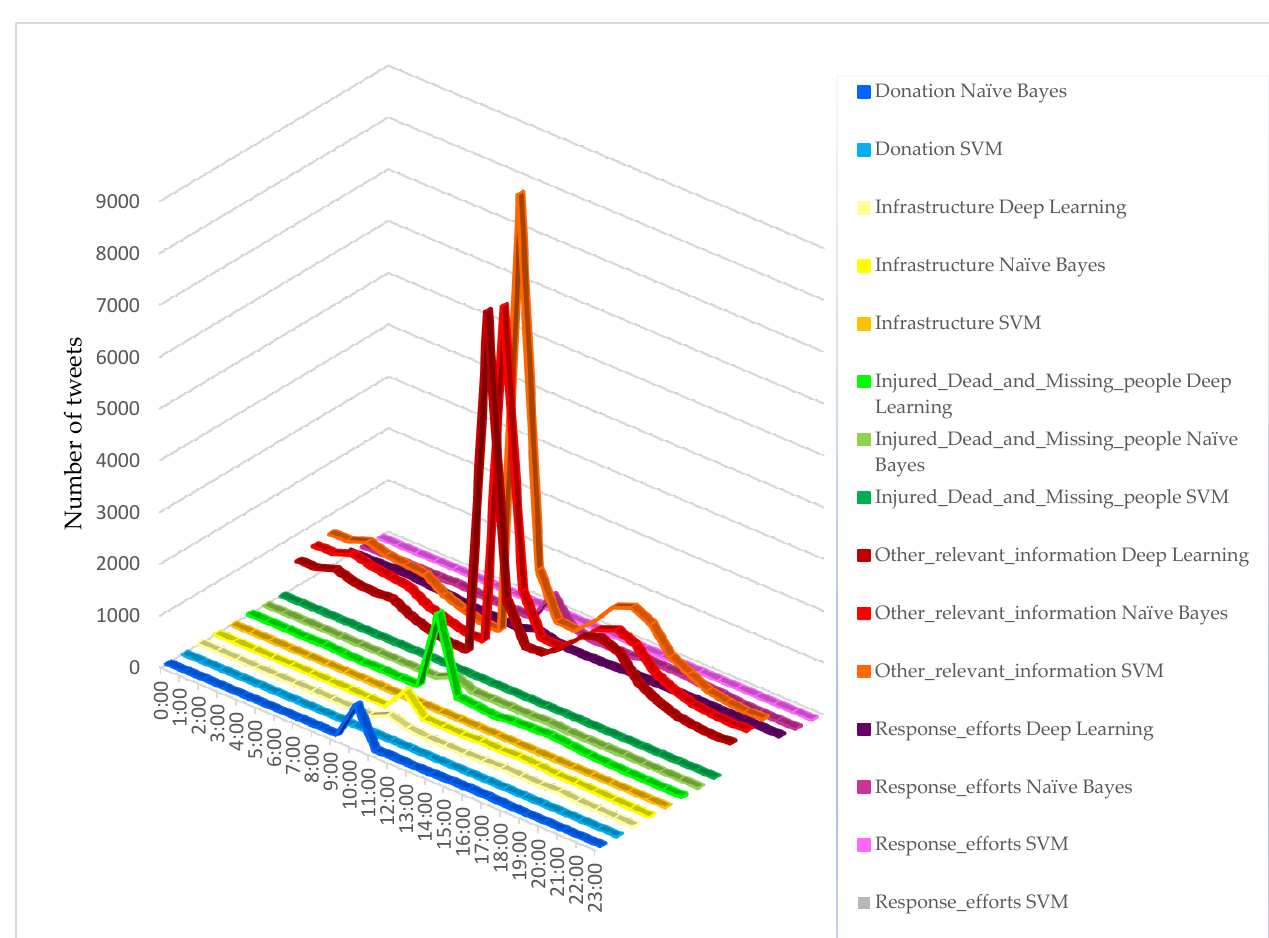
Figure 7. Distribution of classified tweets, in 5 classes, per hour on the day of the earthquake (August 24) according to the Naive Bayes, SVM, and deep learning classification algorithms.